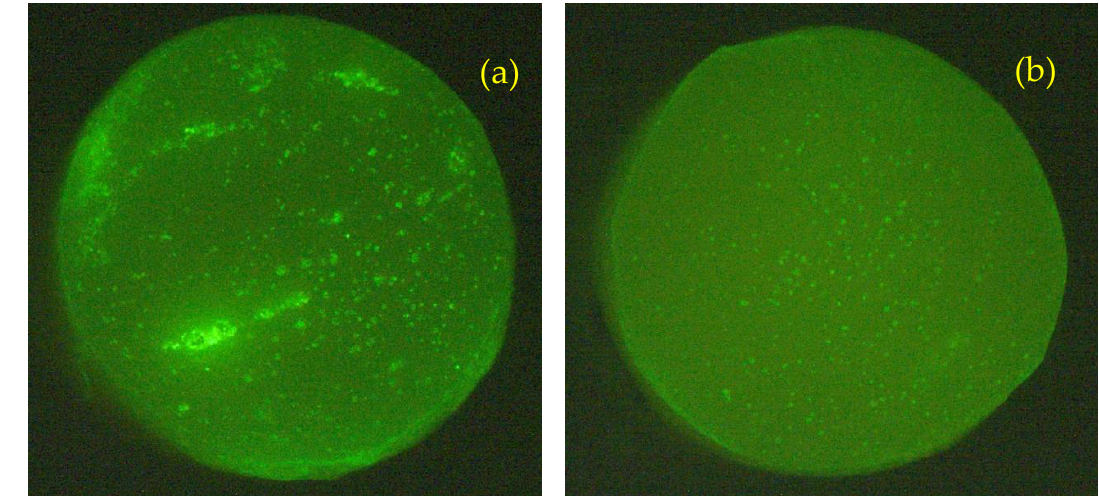
Figure 17. Cross sections of standard bone cement ( a , Simplex P) and a modified formulation ( b , Simplex P + HA-PDLLA 50) photographed under UV light after accelerated degradation in an acidic solution (pH = 4) for 4 weeks. Diameter of specimens: 6 mm. Please note the even higher pore distribution in the modified bone cement specimen ( b ).